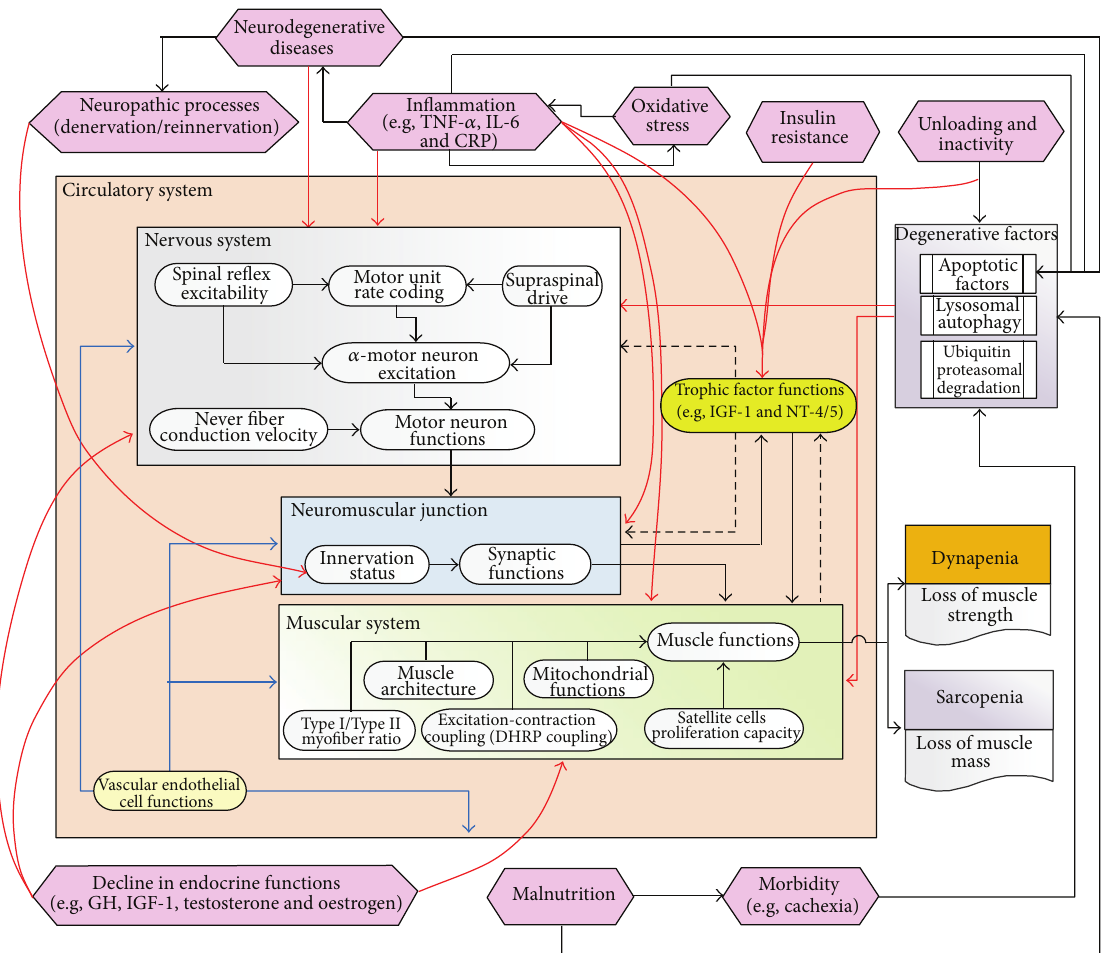
Figure 1: Summary of the neuromuscular mechanism and its relationship with the commonly accepted etiological factors of sarcopenia. The relationships between each of these factors are interlaced in a complex fashion. Black solid lines: positive regulation/reinforcements; black dash lines: positive regulation by the muscular system; red solid lines: negative regulations; blue solid lines: regulation by the